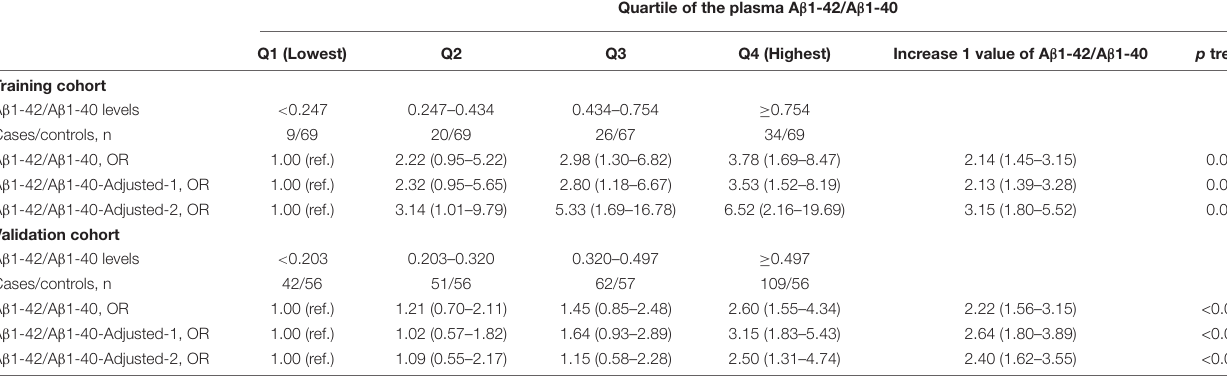
TABLE 3 | Efficacy of the elevated plasma A β 1-42/A β 1-40 ratio in diagnosing MCI in both training and validation cohorts of T2DM